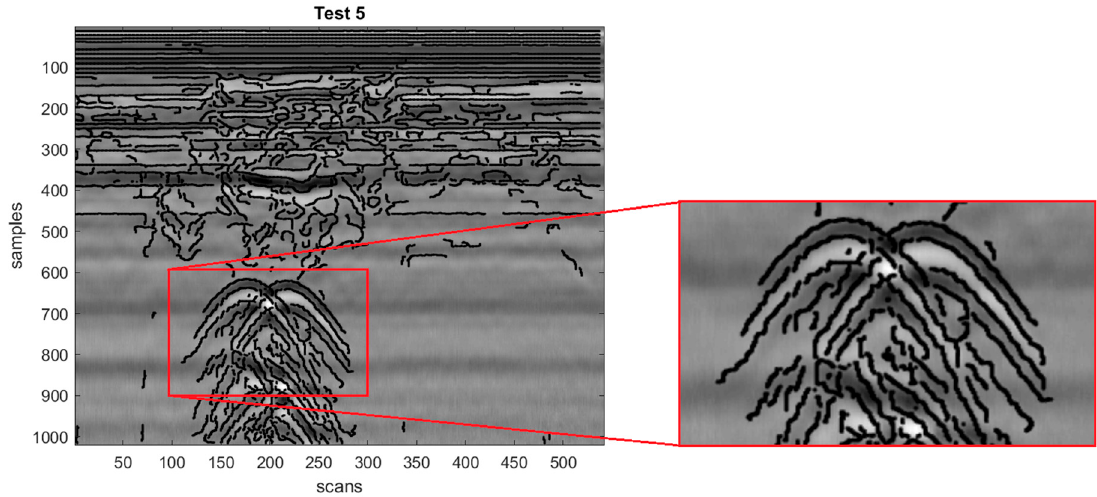
Figure 2. An example of application of Canny edge detection to experimental ground-penetrating radar (GPR) data.